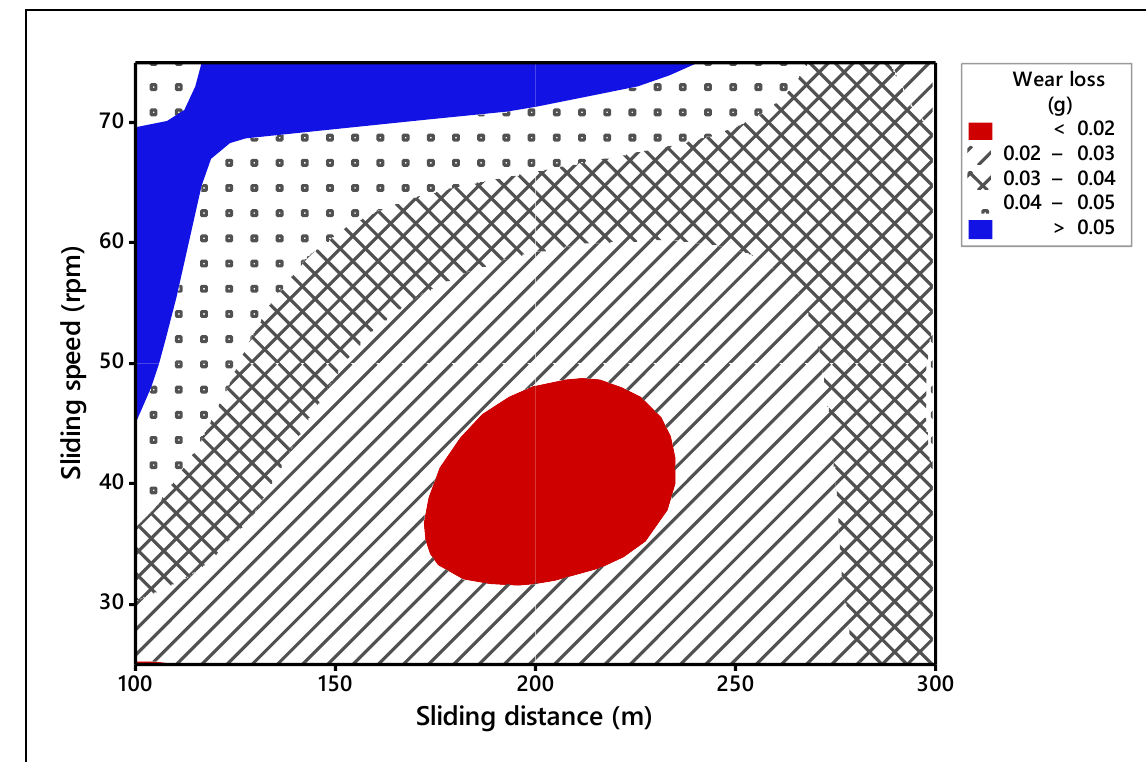
Figure 8. Contour plot for wear loss (Sliding speed vs. sliding distance).